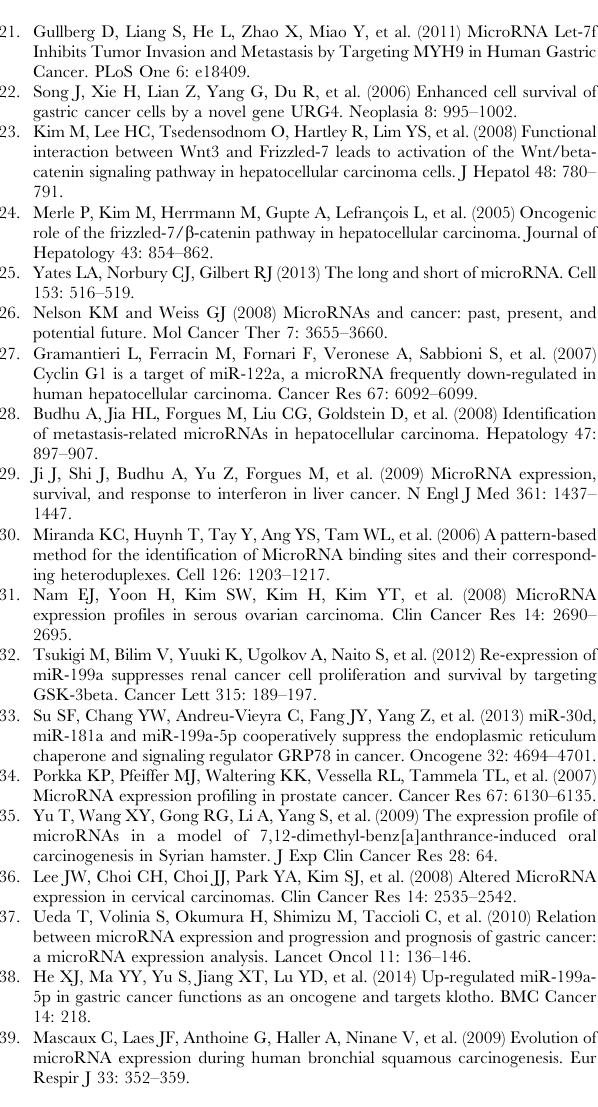
Table S1 The relative expression of miR-199a in all HCC